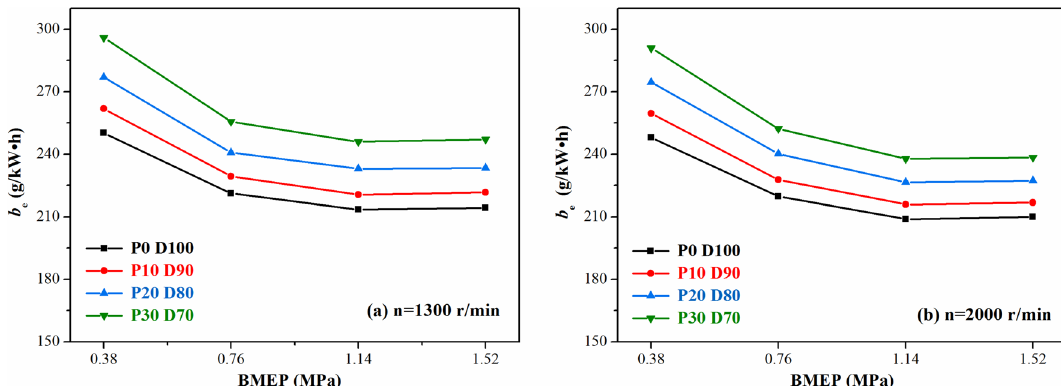
Figure 6. Effects of PODE n blending ratio on effective fuel consumption.